Question: Give a one-sentence summary of this figure.
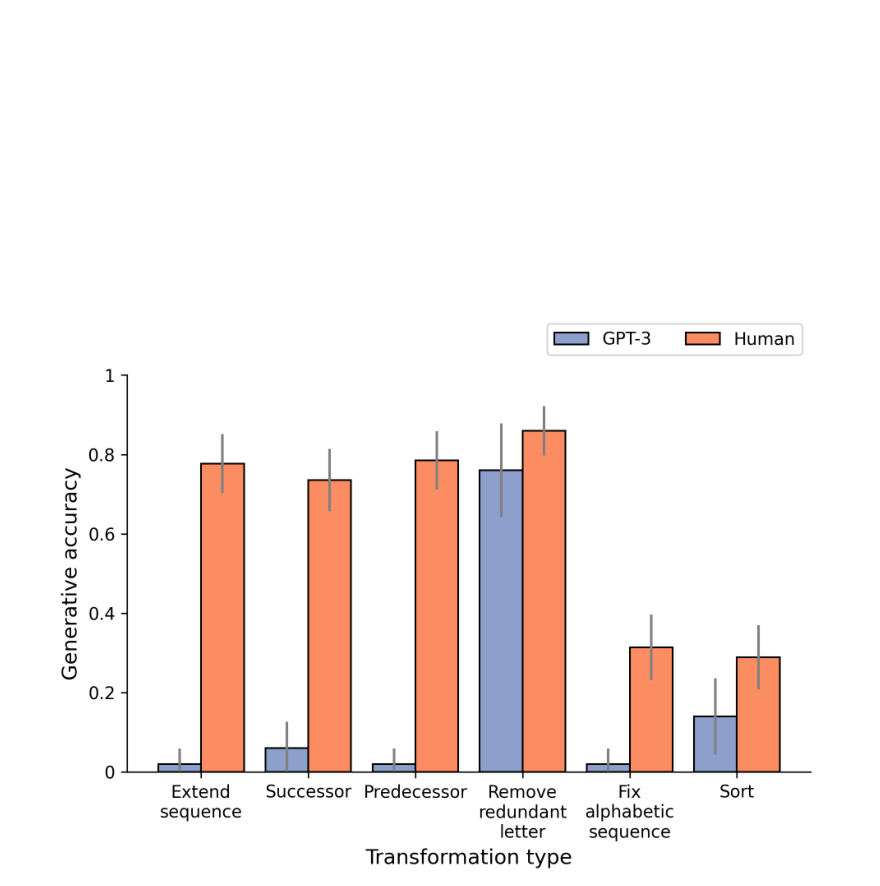
Answer: Comparison between GPT-3’s (blue) and human (orange) performances on modified letter string problems involving a synthetic alphabet and a larger interval size. The transformation types and their order correspond to Figure 6b in the original pa- per. Humans demonstrate significantly higher accuracy compared to GPT-3. Human results represent the average performance of 121 participants (UW undergraduates). Each participant received one randomly selected instance of each problem subtype. GPT-3 results reflect the average performance across all 50 instances. Gray error bars indicate 95% binomial confidence intervals for the average performance across multiple problems.